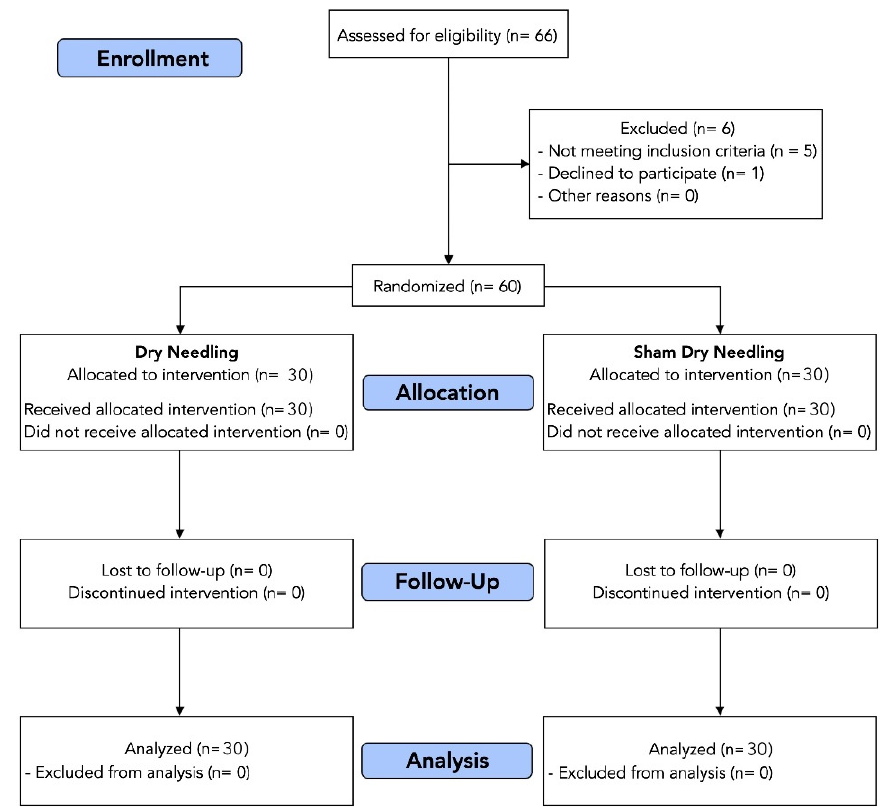
Figure 3. Flow diagram of patients throughout the course of the study.